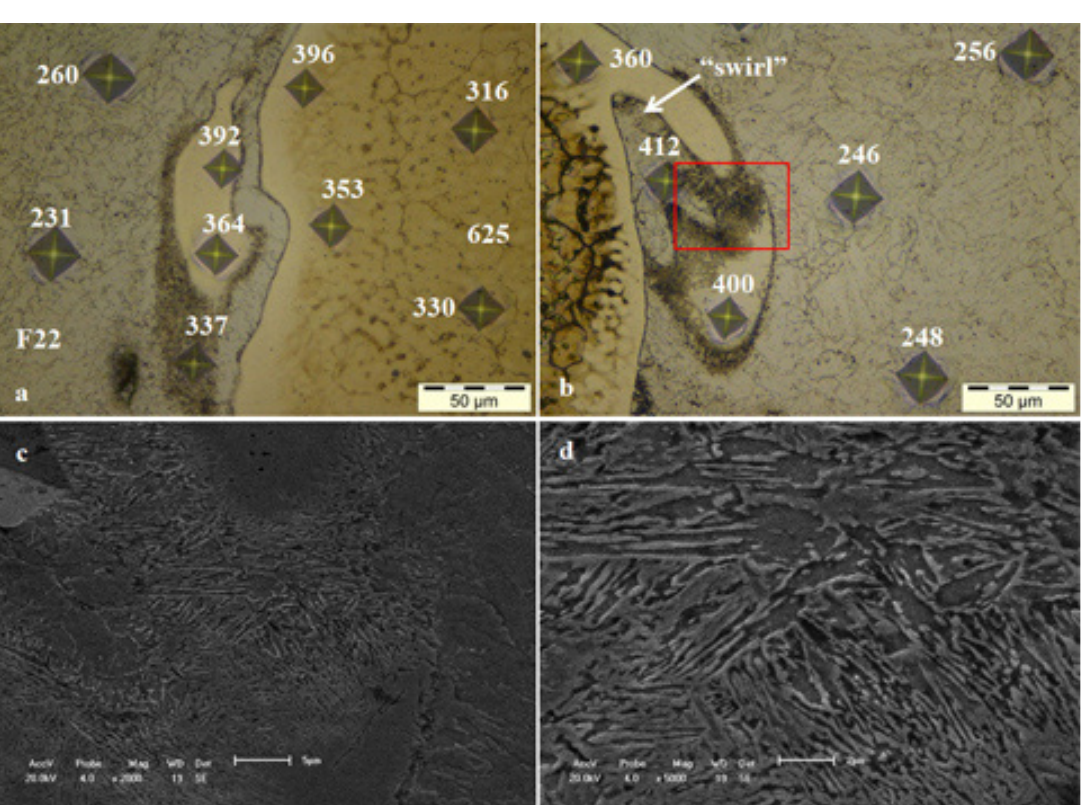
Figure 10. Buttering weld. (a) OM from “islands “ (500x). (b) OM from “swirl” (500x). (c) e (d) SEM of the region comprised by the red rectangle, respectively, (2000x) e (5000x).